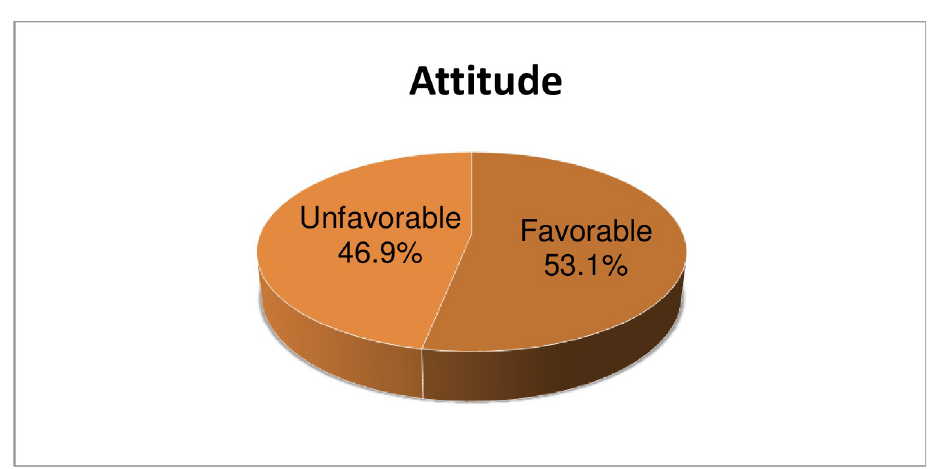
Fig 1. Pie chart showing attitude towards strabismus, among participants in Woreta town, Northwest Ethiopia, 2020 (n = 401).